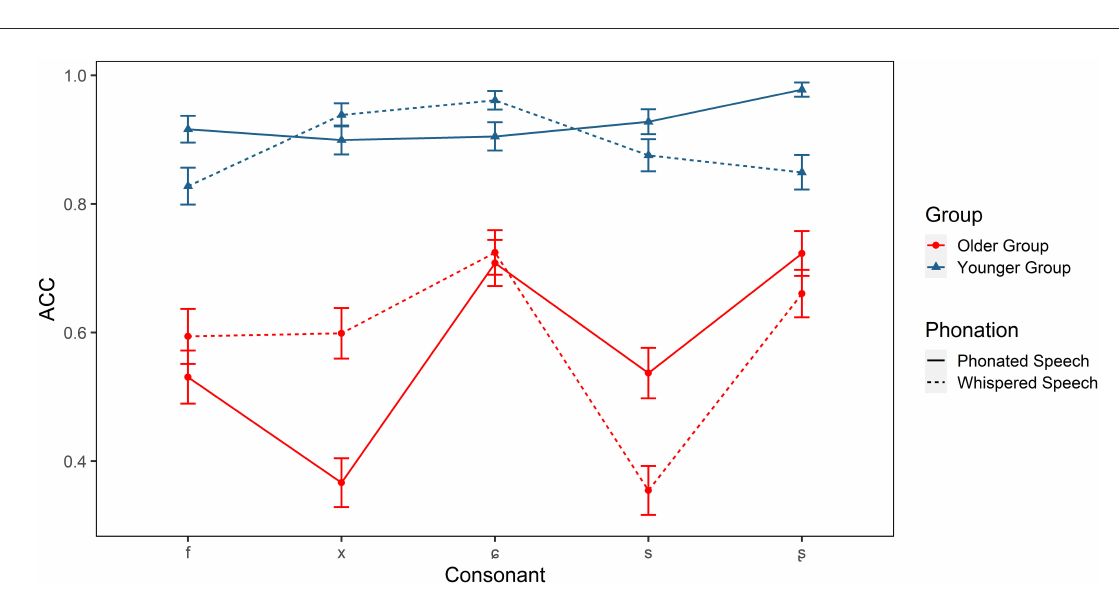
a lower accuracy score of /ts, ts h , t C /, ( p < 0.05), but a higher score of /t C h